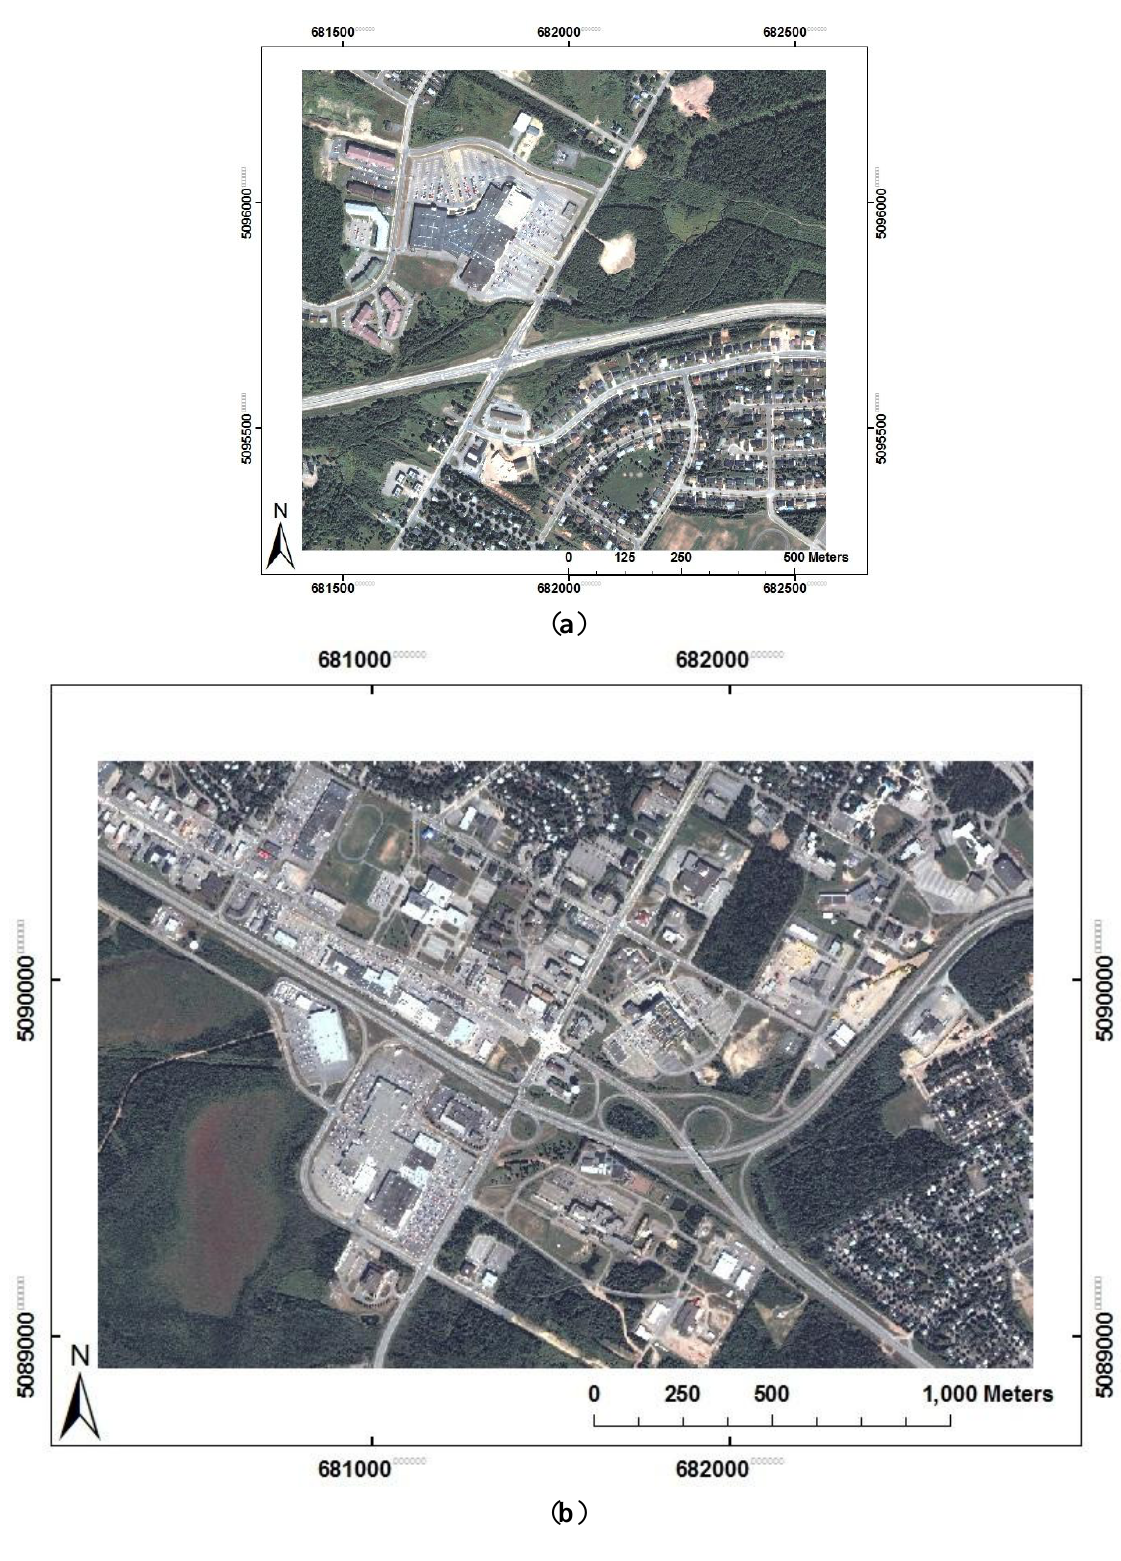
Figure 1. ( a ) Pan-sharpened QuickBird (QB) Pilot image used for developing the rule-set. ( b ) QB Test image in true color